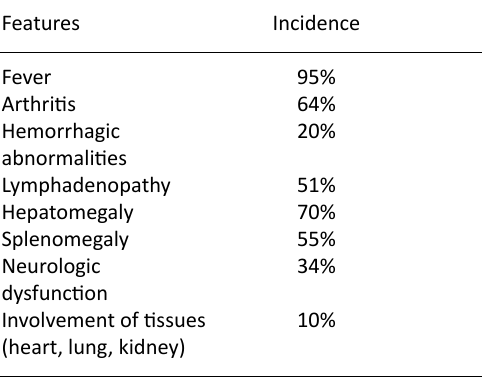
Table 1. Signs and symptoms of MAS